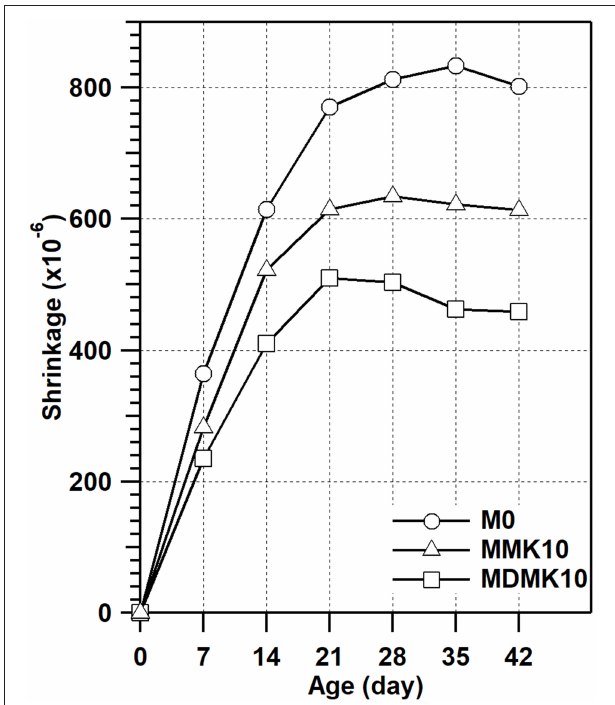
FIGURE 9 | Compressive strength of cement mortar, and mortar with powder or pre-dispersed MK. The results are shown as mean value of 18 specimens of each mix, range of results (f c -max and f c -min), standard deviation and coefficient of variation (size of circle).